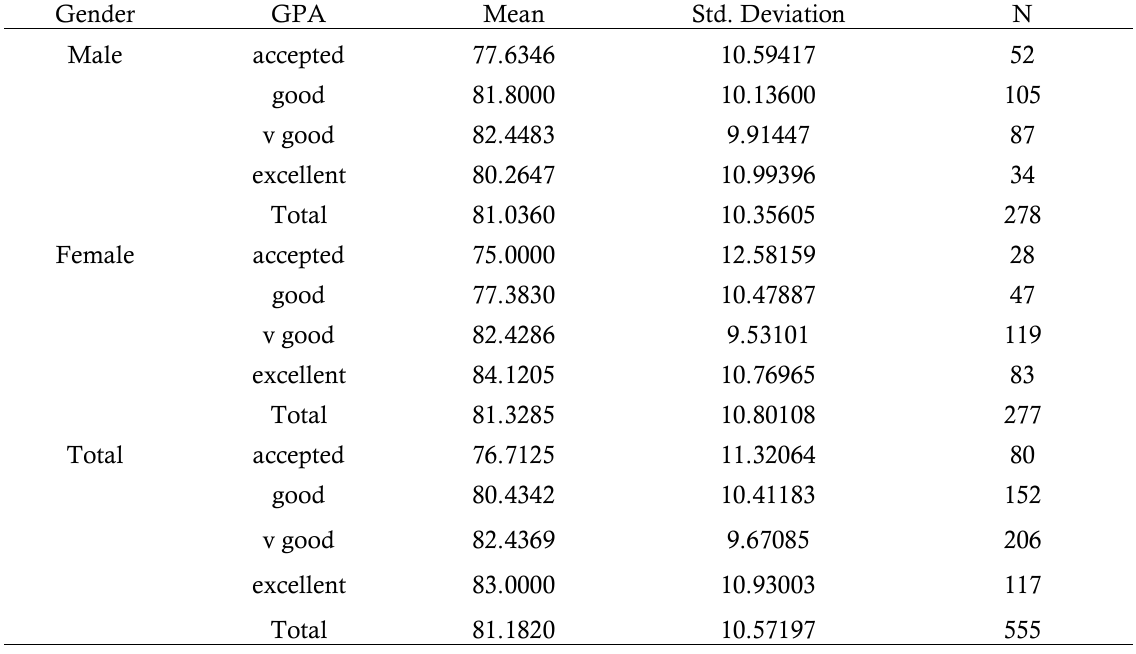
Table 6. Means and standard deviations of CDMSE